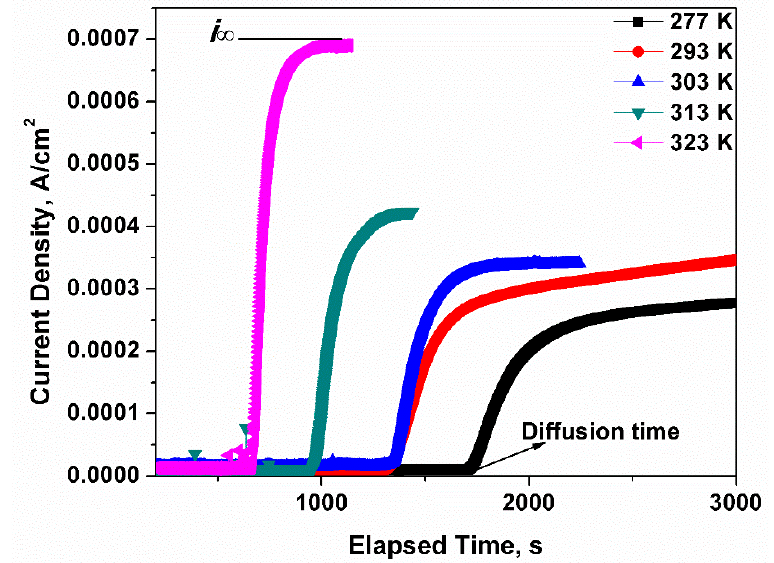
Figure 4. The current density curves of X80 steel. The stable current density increases with the temperature, which means more hydrogen atoms are generated at the surface of the specimen. Namely, the supply of hydrogen atoms increases in the specimen as the temperature increases. As the hydrogen density and diffusivity are not related to the strength of the steel, the X80 test results can be applied to other steels.